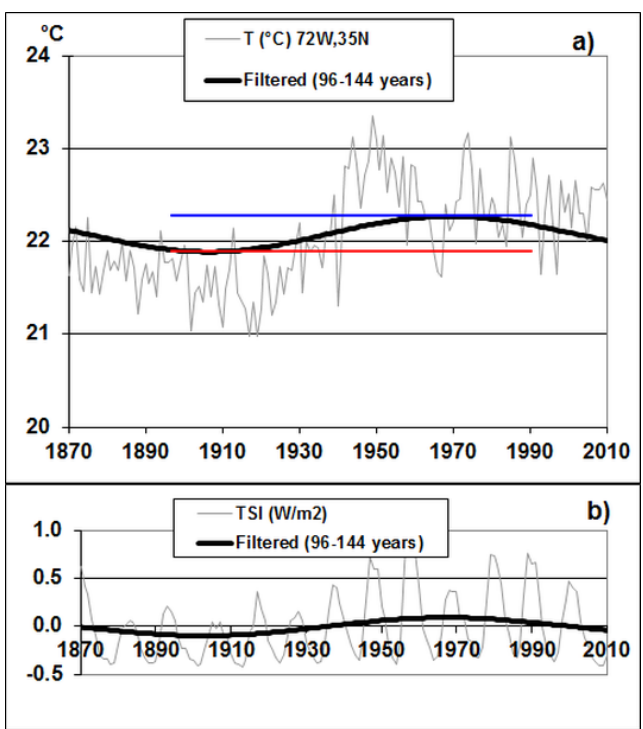
Figure 3. SST at 72° W, 35° N ( a ) and Total Solar Irradiance (TSI) deduced from sunspot number ( b ). The two signals, which are defined jointly over 144 years, are filtered in the band 96 – 144 years. In ( a ) the amplitude of the SST anomaly is half the difference between the blue and red lines. It is very little sensitive to edge effects because SST recovers at the end of the observation period nearly the value it had at the beginning (the data can be considered as pseudo-periodic over that period). The phase is the time elapsed between two maxima expressed in ( a ) and ( b ): in this case, the phase difference between SST and TSI is low, both maxima occurring nearly in 1969.